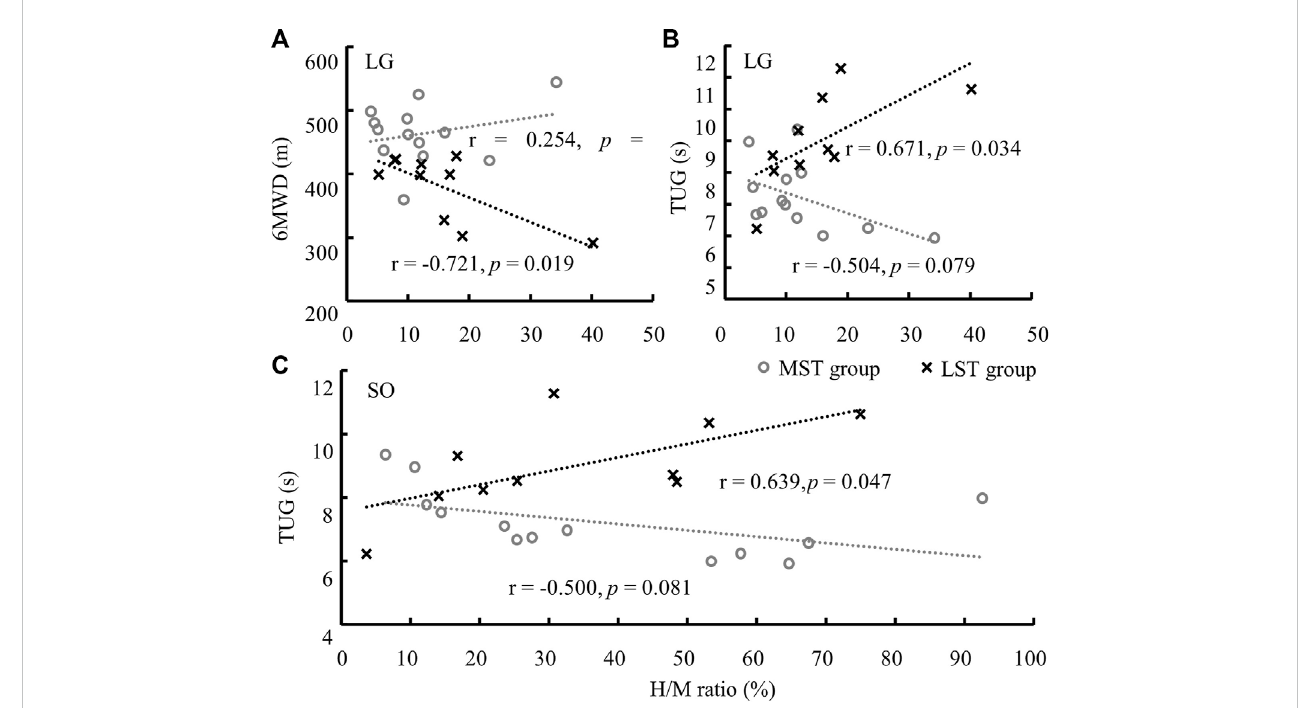
FIGURE 5 Signi fi cant linear relationships were only observed in LST between the H/M ratio of LG and 6MWD (A) , and TUG (B) , and of SO and TUG (C) . Note: the range of SO H/M ratio was much greater than that of the LG.